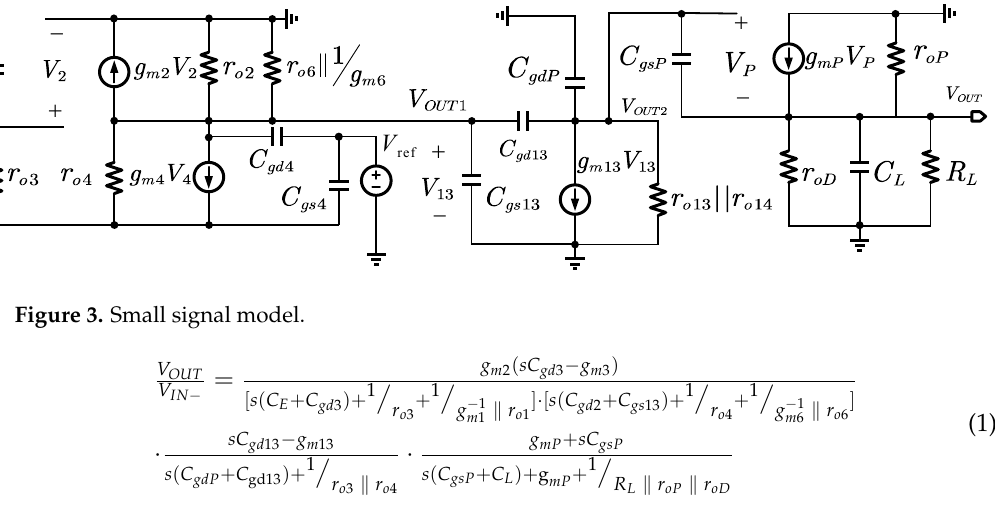
Figure 2. The second stage is composed of common source amplifier. Because of the complementary design, rail-to-rail input and output can be achieved. By introducing the internal mismatch of a differential pair, the common source amplifier has low power consumption. Compared with other RRIO amplifiers, its input stage structure is simpler. The internal poles of the amplifier are pushed to high frequencies through dynamic pole com- pensation with high stability in the loop.